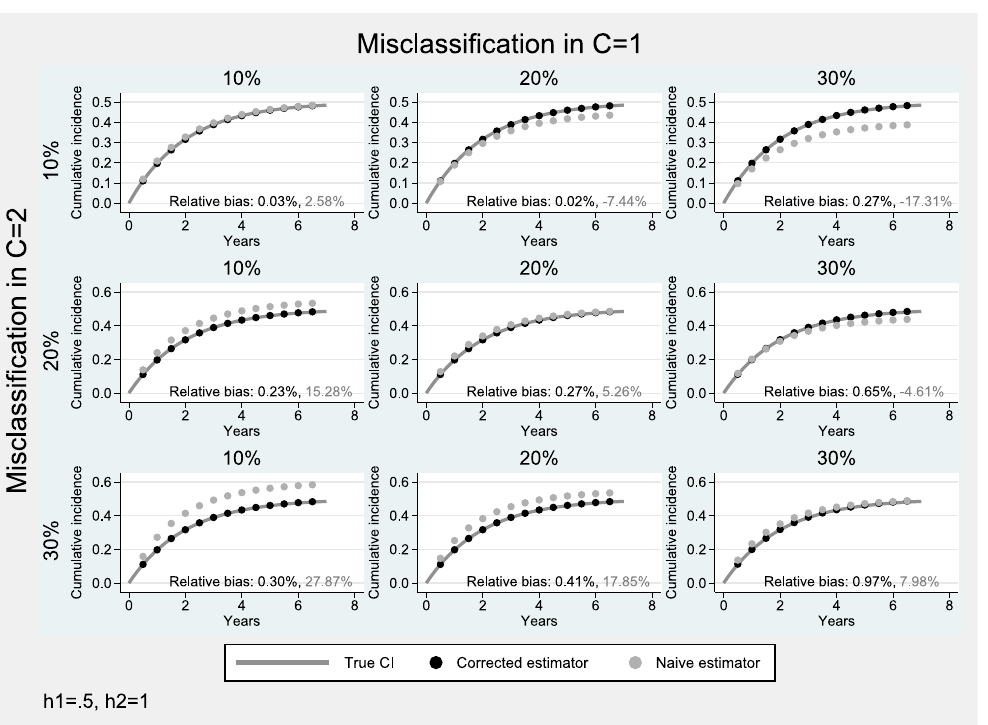
Fig 5. Simulation results for the case of bidirectional misclassification: Hazard parameter for the primary endpoint lower than that of the competing event ( h 1 = 0.5, h 2 = 1). Solid lines correspond to the true cumulative incidence whereas dotted lines to the estimates from the non-parametric Aalen-Johansen estimator for the primary endpoint.